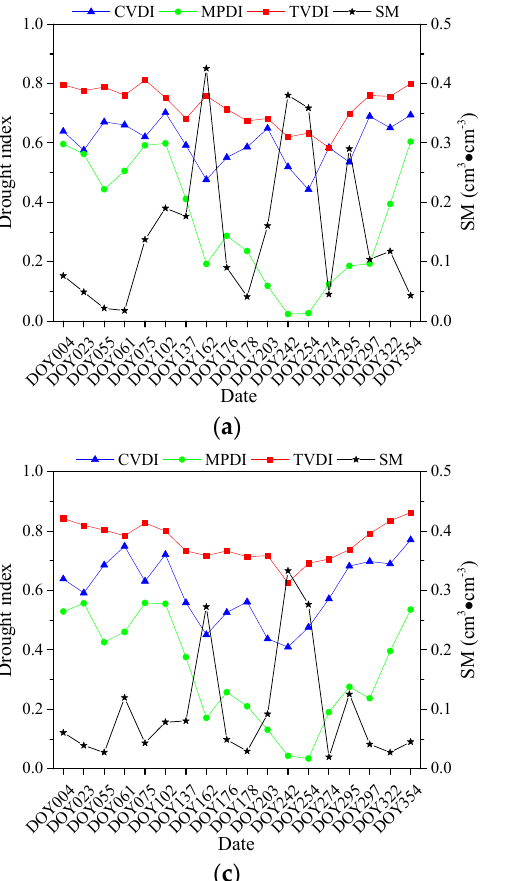
Figure 9. Scatterplots established between the three drought indices and SM, monthly precipitation in the four main land cover types including ( a ) Cropland, ( b ) Forest, ( c ) Grassland and ( d )